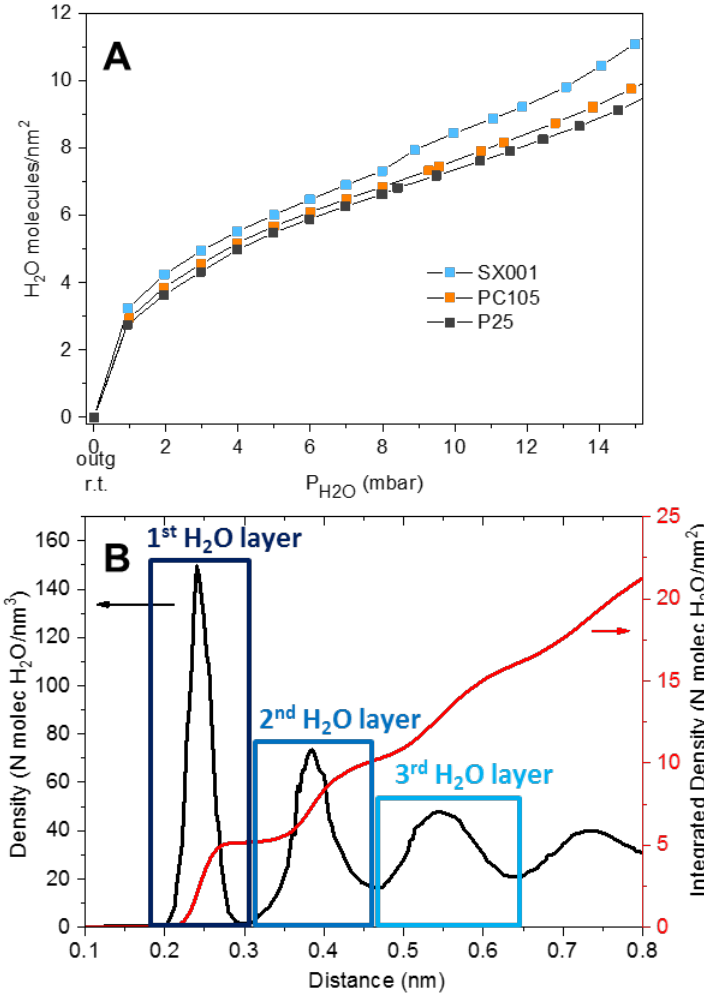
Figure 7. ( A ) Water adsorption isotherms at 298 K obtained from microgravimetric measurements. The samples have been previously outgassed at room temperature (r.t.). ( B ) Water density profile (black curve) and corresponding integration (red curve) in the direction normal to the (101) TiO 2 anatase surface (the plane formed by the topmost surface titanium atoms is set as 0). The molecular dynamics simulation data (black curve) have been extracted from Figure 3b of ref. [35].